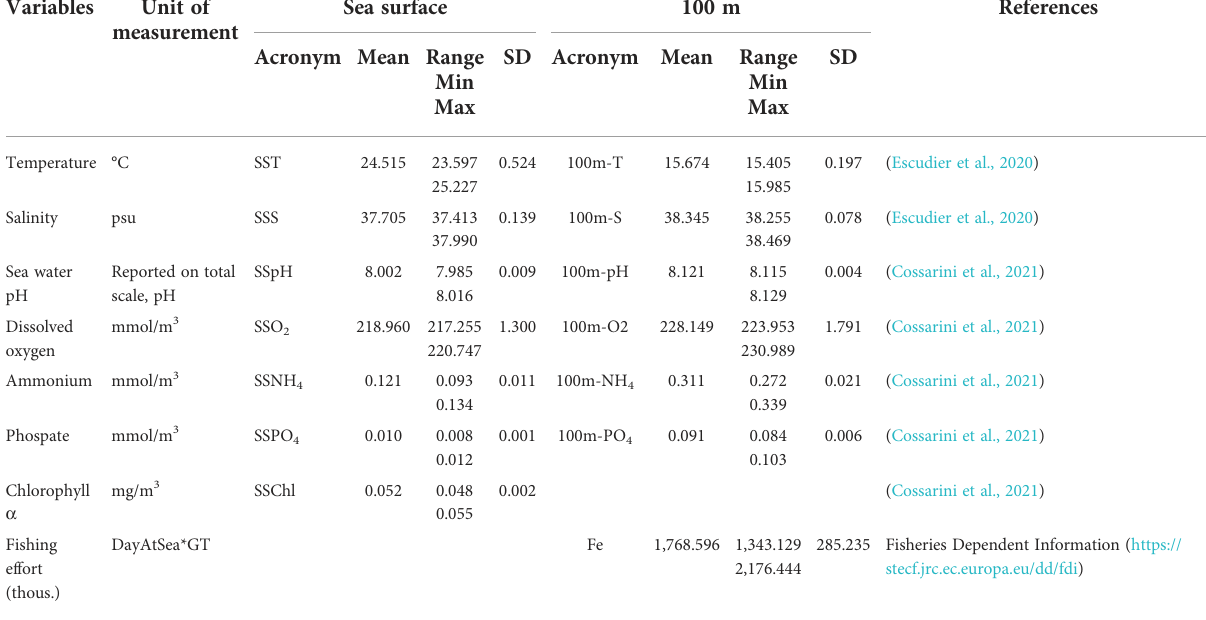
TABLE 1 Descriptive statistics [mean, range, and standard deviation (SD)] for selected predictor variables.